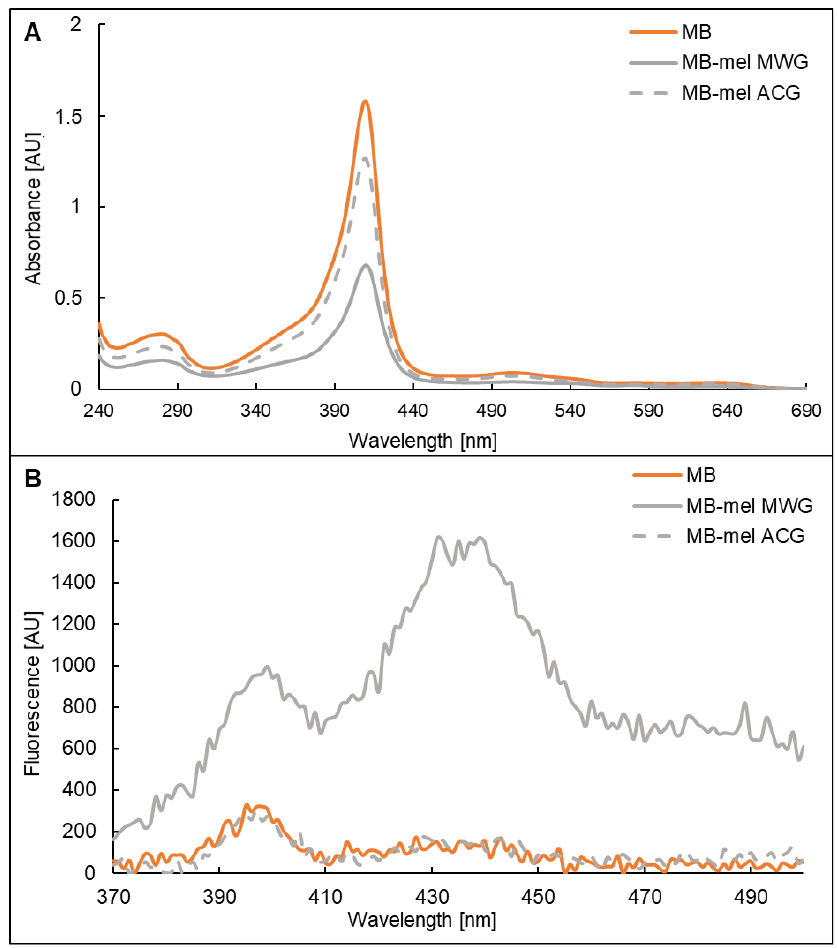
Figure 2. Absorption ( A ) and fluorescence ( B ) spectra properties of the water solutions of MB (orange line), MB-mel MWG (grey solid line), and MB-mel ACG (dashed grey line) at a concentration of 0.5 mg/mL. Absorption spectra were recorded in a range from 240 to 690 nm, and fluorescence spectra upon excitation at 350 nm were recorded in a range from 370 to 500 nm.